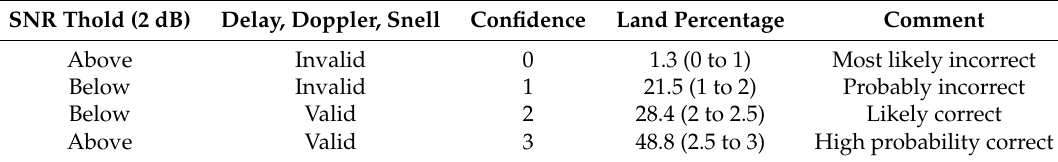
Table 2. Summary of land geolocation confidence flag